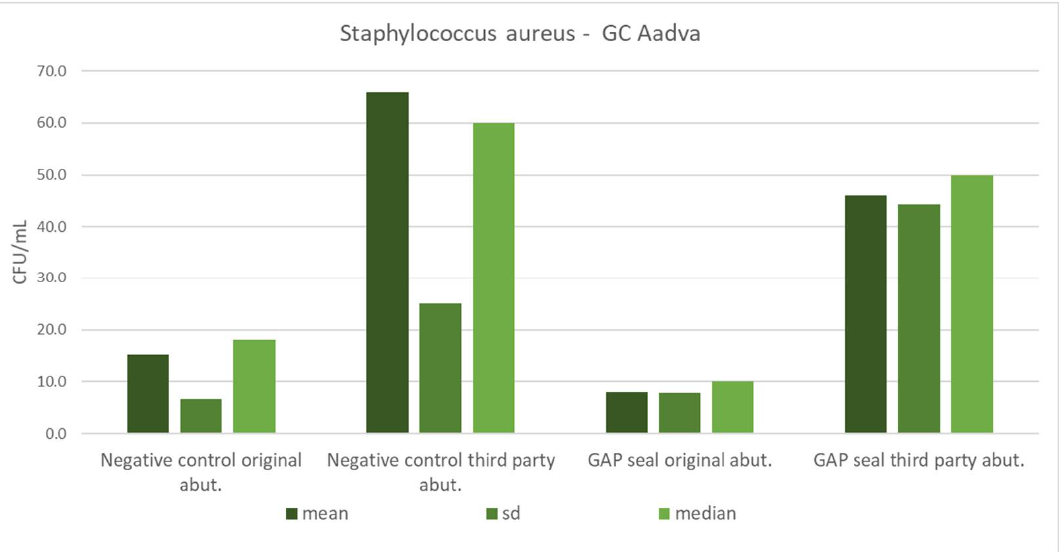
Figure 12. Mean counts of Staphylococcus aureus detected on the internal surface of GC implants depending on the abutment fabrication method (original and third-party) and the need for the use of the gap sealing material.